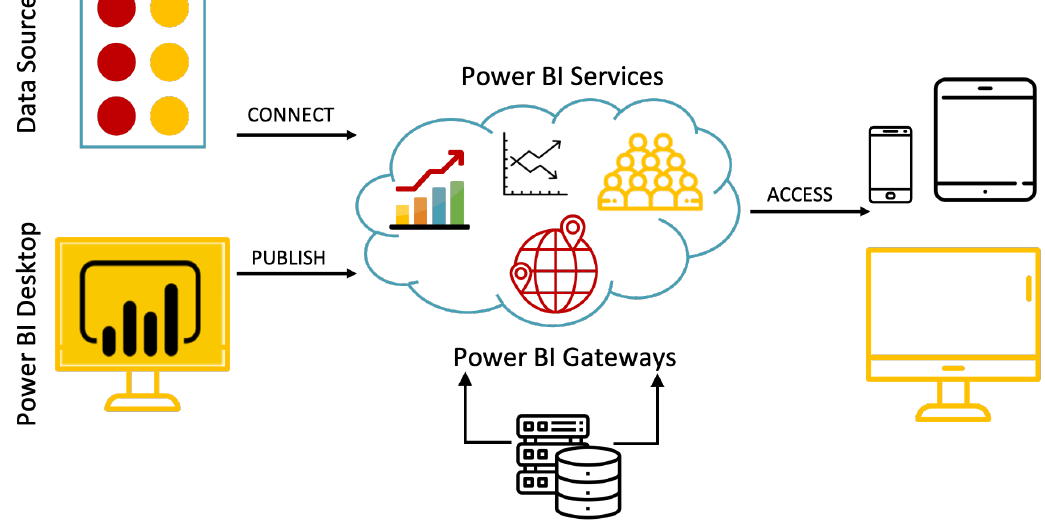
Figure 8. Power BI (Business Intelligence) architecture. Adapted from Reference